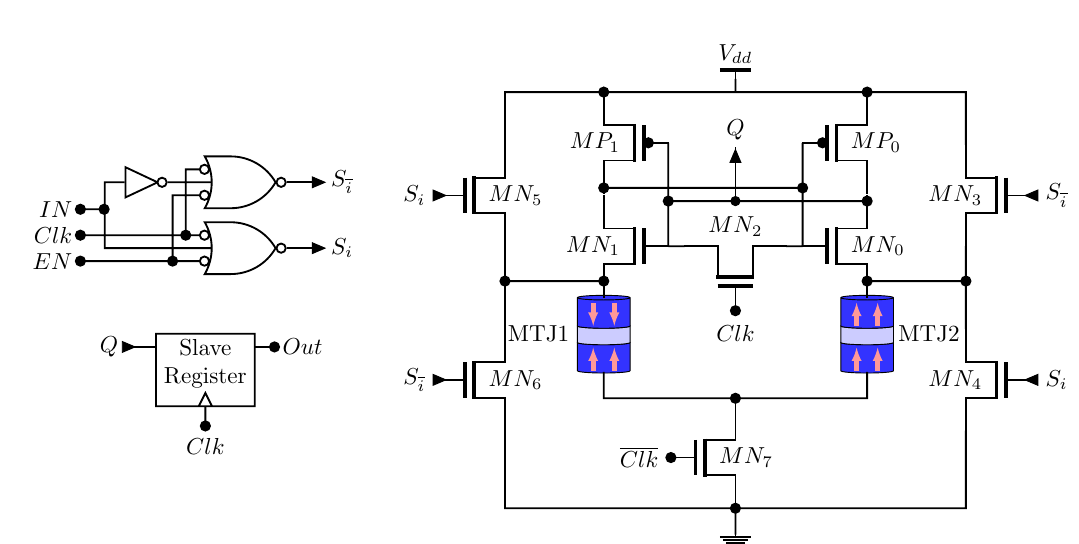
Figure 9. Spin-MTJ based Non-Volatile Flip-Flop proposed in Reference [59].